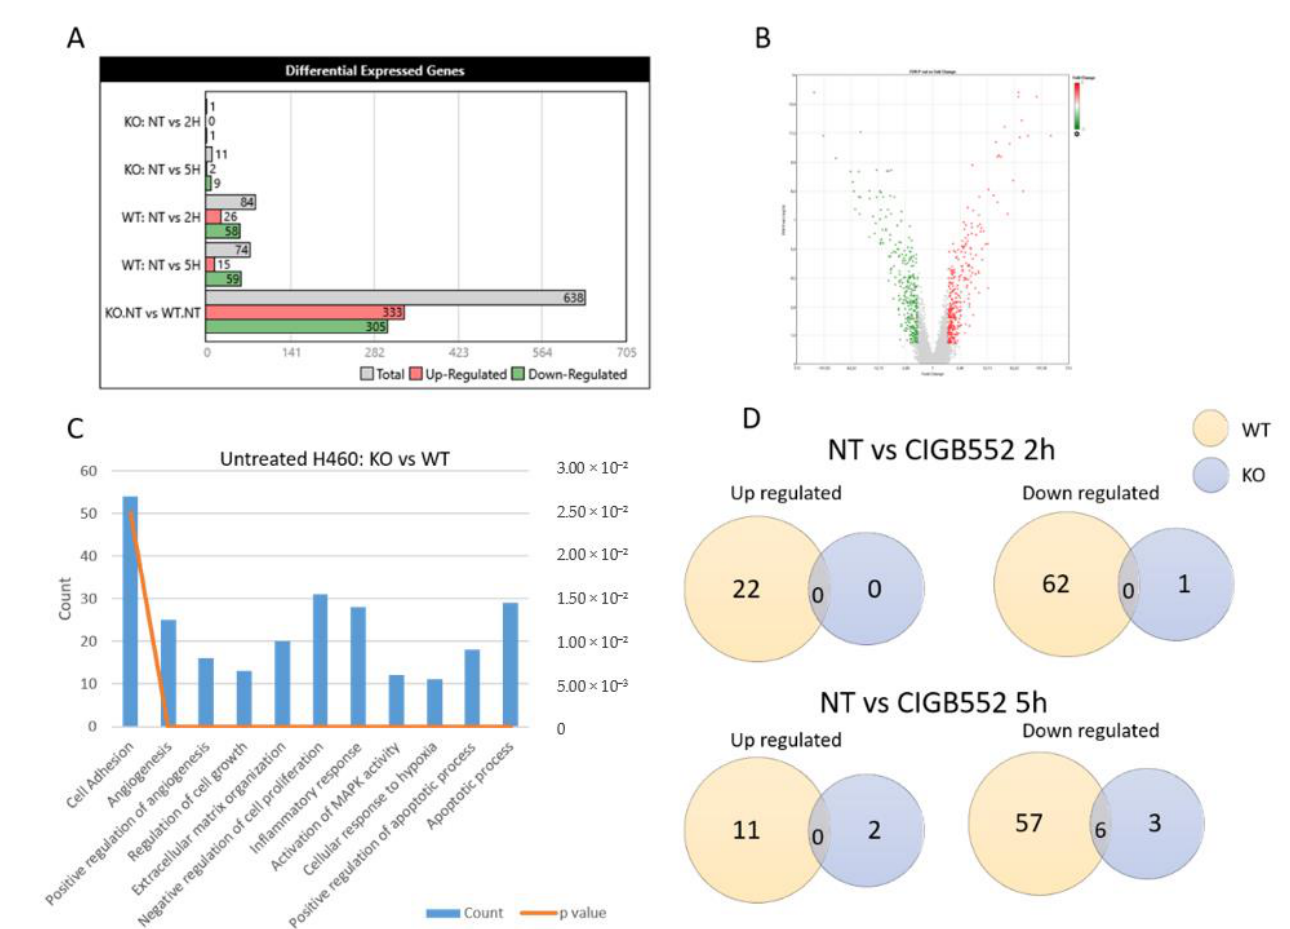
Figure 5. DNA microarray in H460 WT and KO cells. Cells were treated with 25 µM or without CIGB-552 for 2 and 5 h. ( A ) Differential expressed genes (DEGs) among different conditions. ( B ) Volcano plot of DEGs in WT and KO cell line without treatment. ( C ) Functional enrichment of biological processes of DEGs in H460 WT and KO. ( D ) Venn diagram for comparison of DEGs up- and downregulated in KO and WT cells without treatment (NT) and treated with CIGB-552. Table 2. Selected DEGs in untreated H460 COMMD1 KO vs. WT.